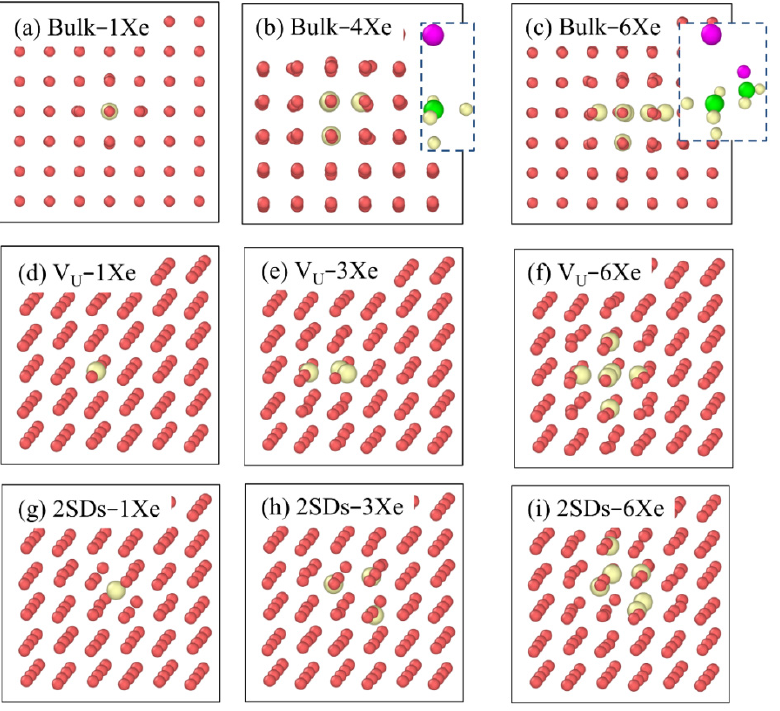
Figure 1. Relaxation configuration diagrams of different UO 2 systems after adding Xe atoms. ( a – c ) are 1, 4, and 6 Xe in the defect-free system, respectively; ( d – f ) are 1, 3, and 6 Xe in the system containing U vacancies, respectively. ( g – i ) are 1, 3, and 6 Xe in the system containing double Schottky vacancies, respectively. The dashed frames are the schematics of the squeezed interstitial atoms. The red, yellow, green, and purple balls represent U atoms, Xe atoms, U vacancies, and U interstitial atoms, respectively. The O atoms are ignored.